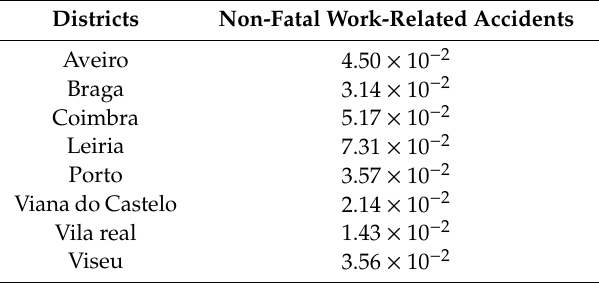
Table A1. Non-fatal work-related accidents per worker.